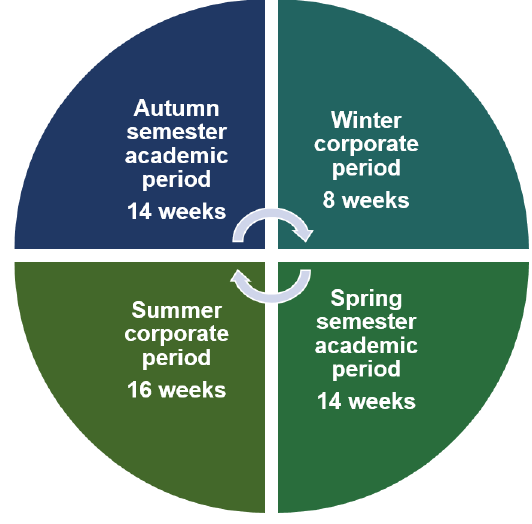
Fig. 1. The Hungarian dual study